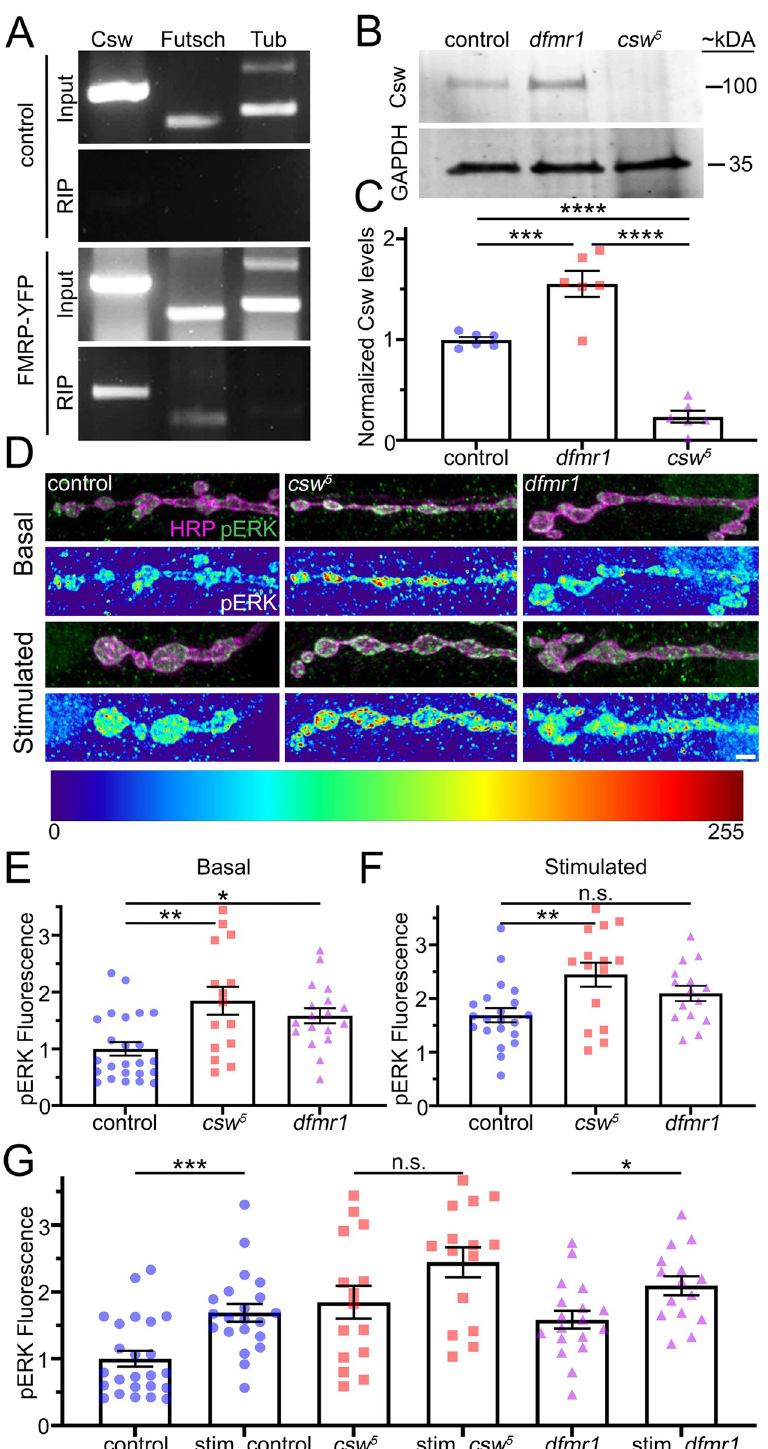
Fig 6. FMRP binds csw mRNA to elevate neuronal Csw and presynaptic pERK levels. (A) RIP control (Tubby::GFP, top) and FMRP (FMRP::YFP, bottom), with csw , futsch (positive control), and α -tubulin (negative control) RNAs. ( B) Western blot for Csw (100 kDa, top) and GAPDH control (35 kDA, bottom) w 1118 control, dfmr1 50M null, and csw 5 null. ( C) Quantification of Csw levels normalized to GAPDH using one-way ANOVA followed by Tukey’s multiple comparisons. (D) Representative NMJ images of w 1118 control, csw 5 null, and dfmr1 50M null colabeled for